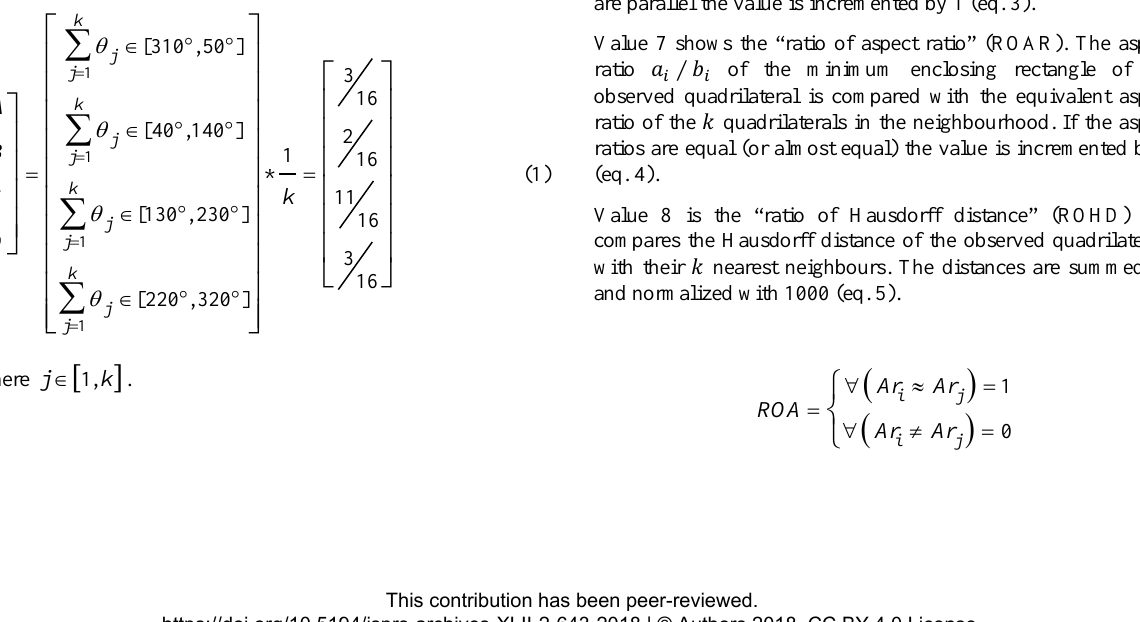
Figure 4. Starting from the observed quadrilateral in the middle, quadrilaterals in the neighbourhood (marked by a red dot) fall into one (in overlapping regions two) quadrant(s) A, B, C, or D depending on their angle . 𝜃𝜃 These four values are not rotation invariant but since digitalized historical images are almost always upright this fact is negligible. Additionally, a region of 5° on both sides of the axes was added to prevent false assignments. The quadrilaterals in the neighbourhood of two homologue quadrilaterals are thus in the same quadrant and the descriptor values are equal.